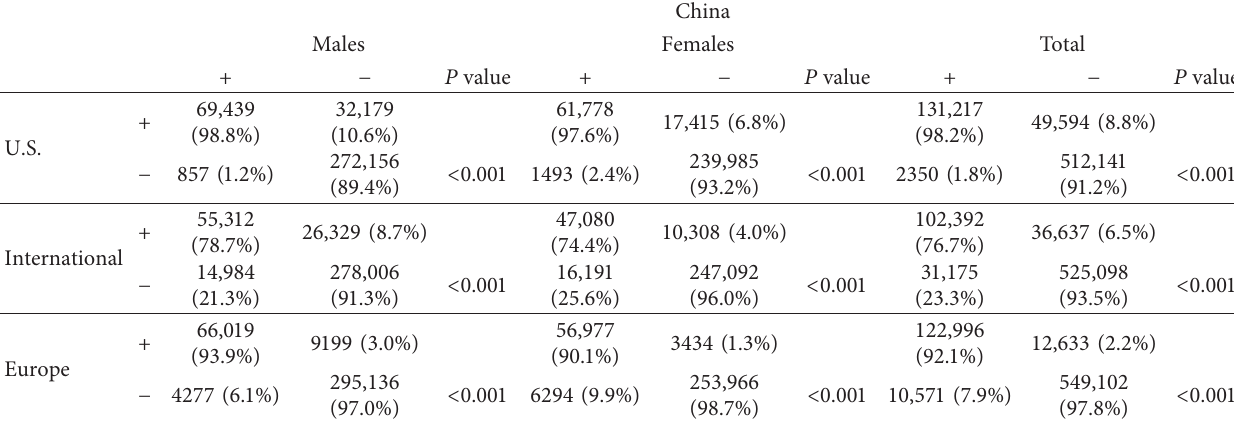
Table 4: Consistency analysis for identifying high blood pressure based on China and the other 3 reference systems.